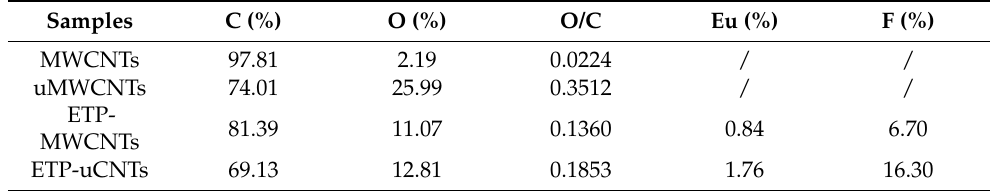
Table 1. XPS analysis results for MWCNTs, uMWCNTs, ETP-MWCNTs and